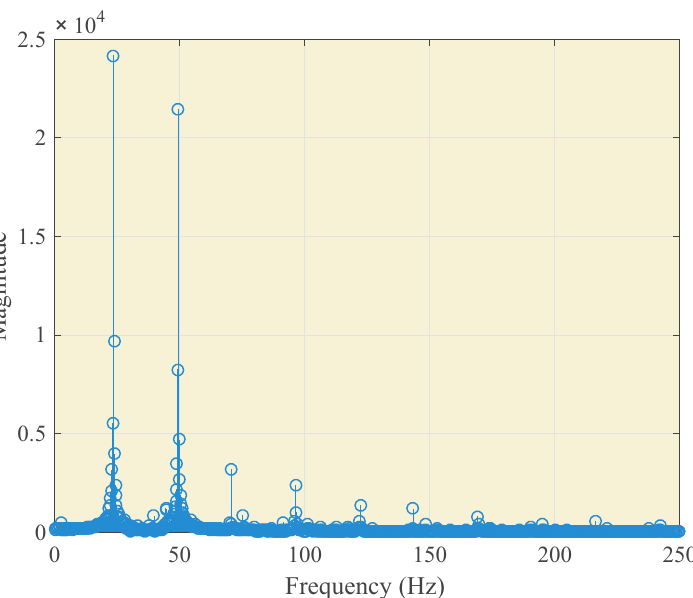
Figure 6. Line-to-earth fault and ferroresonance event. Spectrum of phase A voltage during the ferroresonance